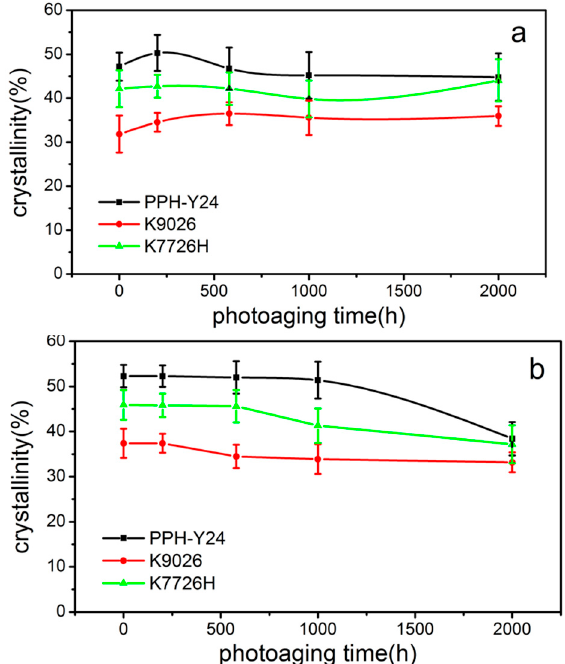
Figure 7. Crystallinity of PP resins during different photoaging time (( a ) crystallinity from the first heating curve; ( b ) crystallinity from the second heating curve).